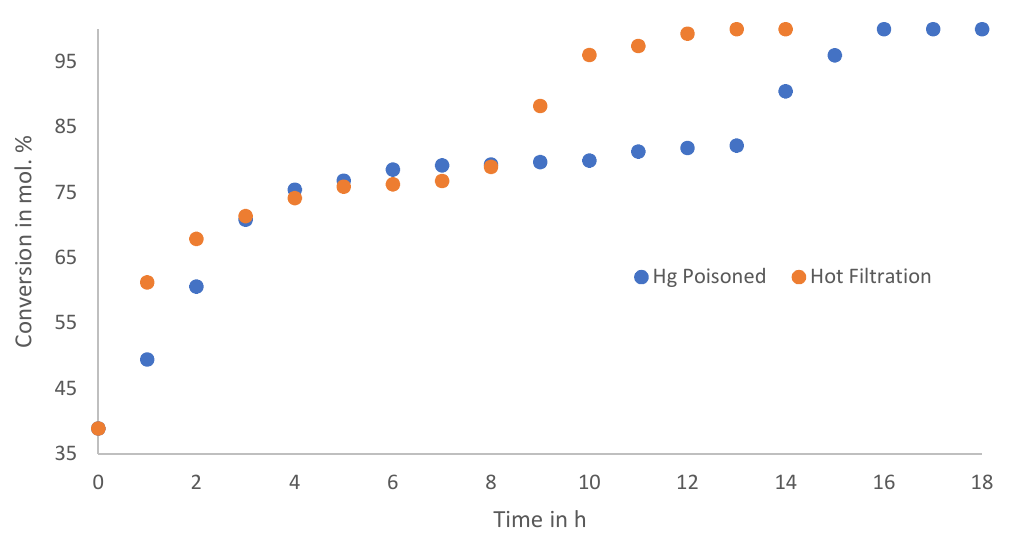
Figure 8. Hot reaction filtrate and Hg 0 -poisoned reaction filtrate to 100% conversion.